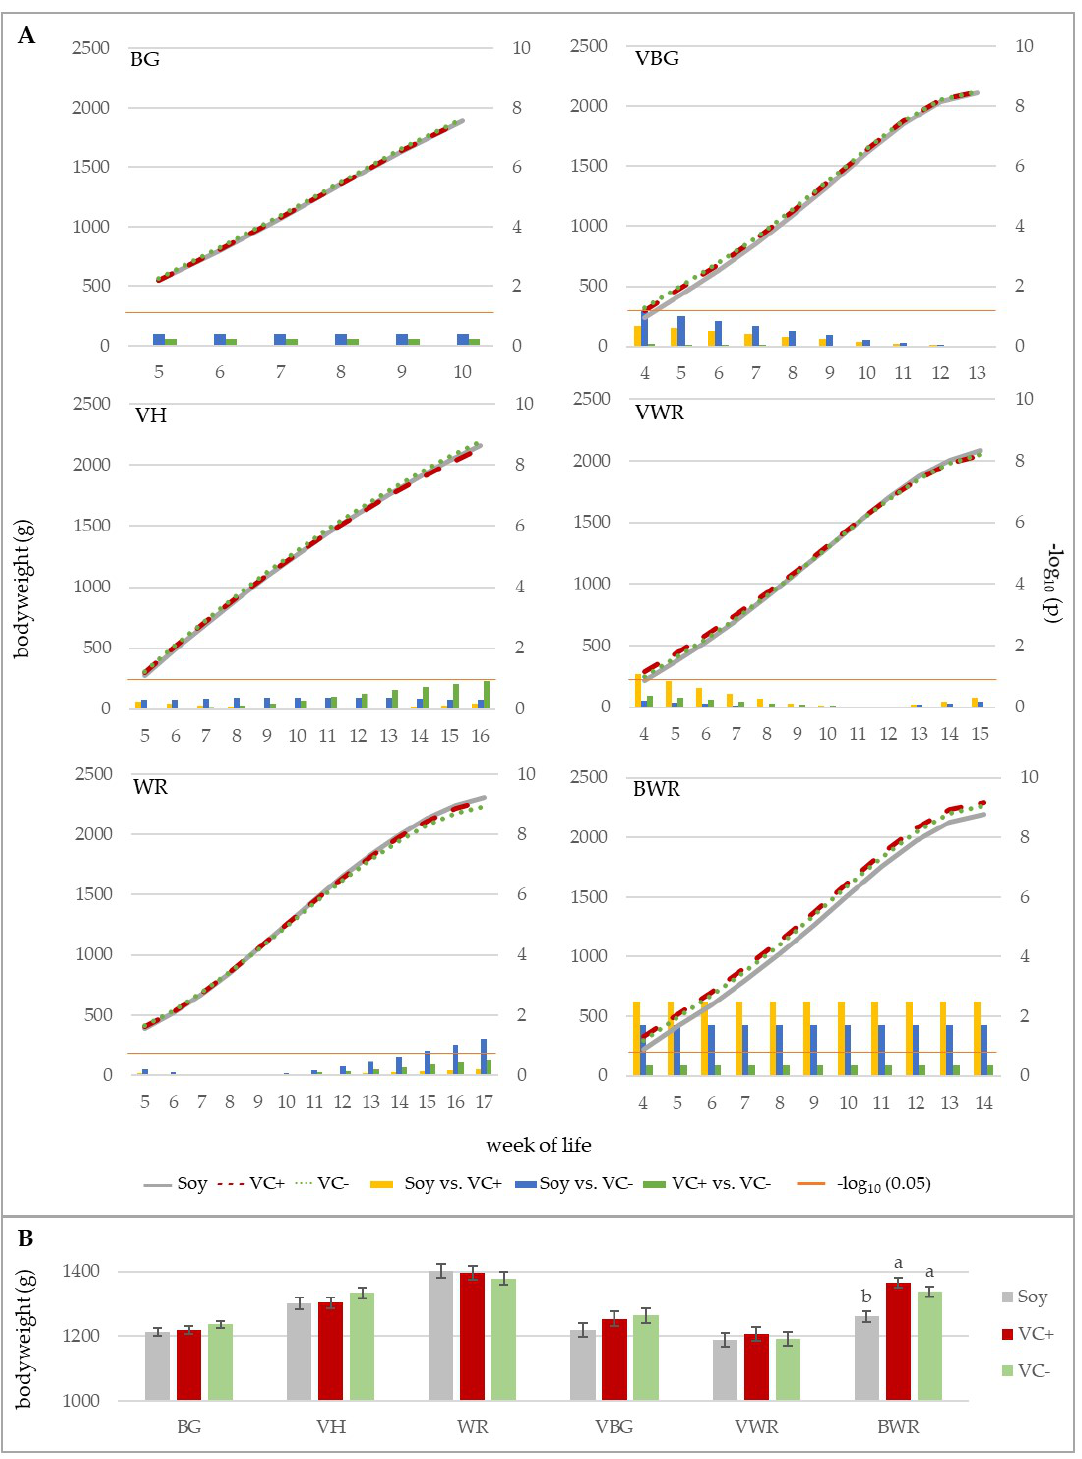
Figure 2. E ff ect of feeding treatment on bodyweight development within genotypes ( A ) and LSMEANS ± SE for the e ff ect of feeding treatment within genotypes adjusted by the mean of age ( B ). In A, curves show bodyweight development for the respective feeding groups. The bar charts exhibit the di ff erences between LS-means of the di ff erent combinations of feeding groups on a weekly base. The orange line represents the significance threshold of p = 0.05. Bars that cross this line imply significant di ff erences between feeding groups in the respective week. In B bars with di ff erent letters within one genotype show significant di ff erences ( p < 0.05).